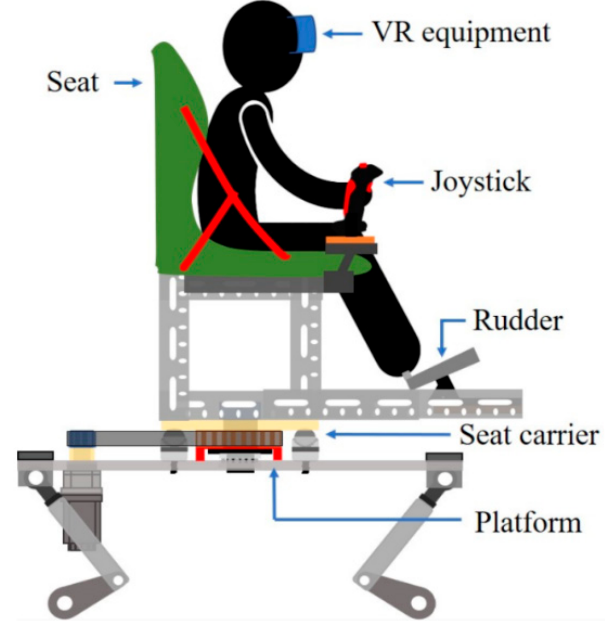
Figure 9. Schematic side view of the seat platform.